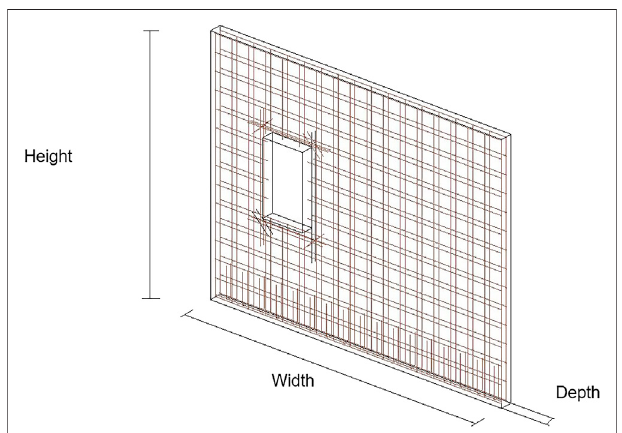
FIGURE 7 | BIM model of the precast concrete wall